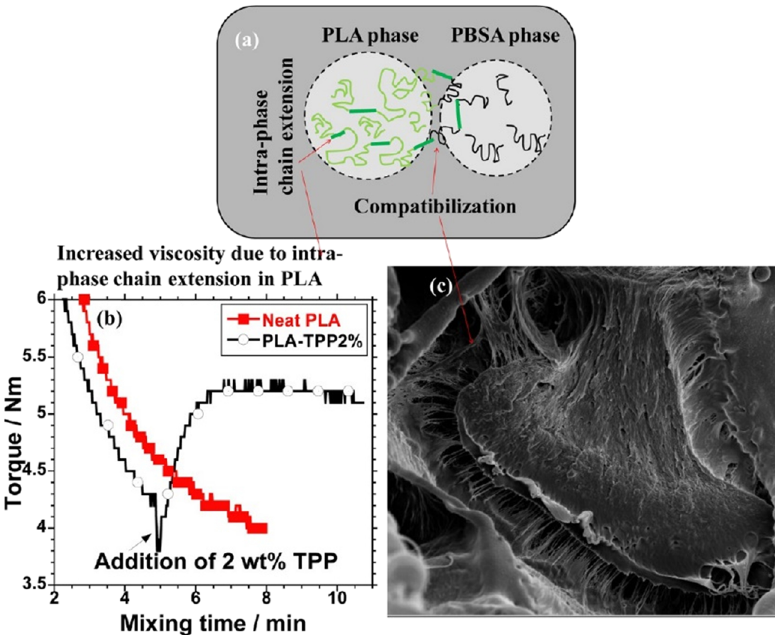
Figure 11: Interphase chain extension and compatibilization model of PLA/PBS blends ( 79 ) . Copyright 2013. Reproduced with permission from American Chemical